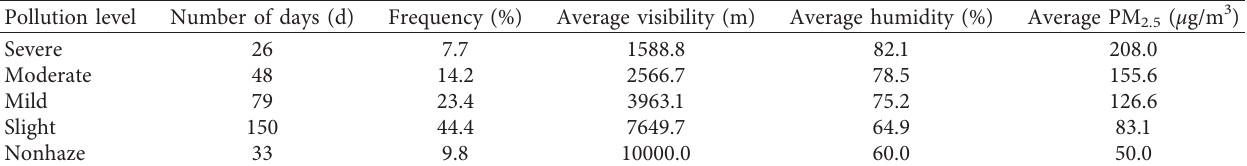
2.5 concentration under different levels of haze days in Xinjin Airport in winter from 2013 to